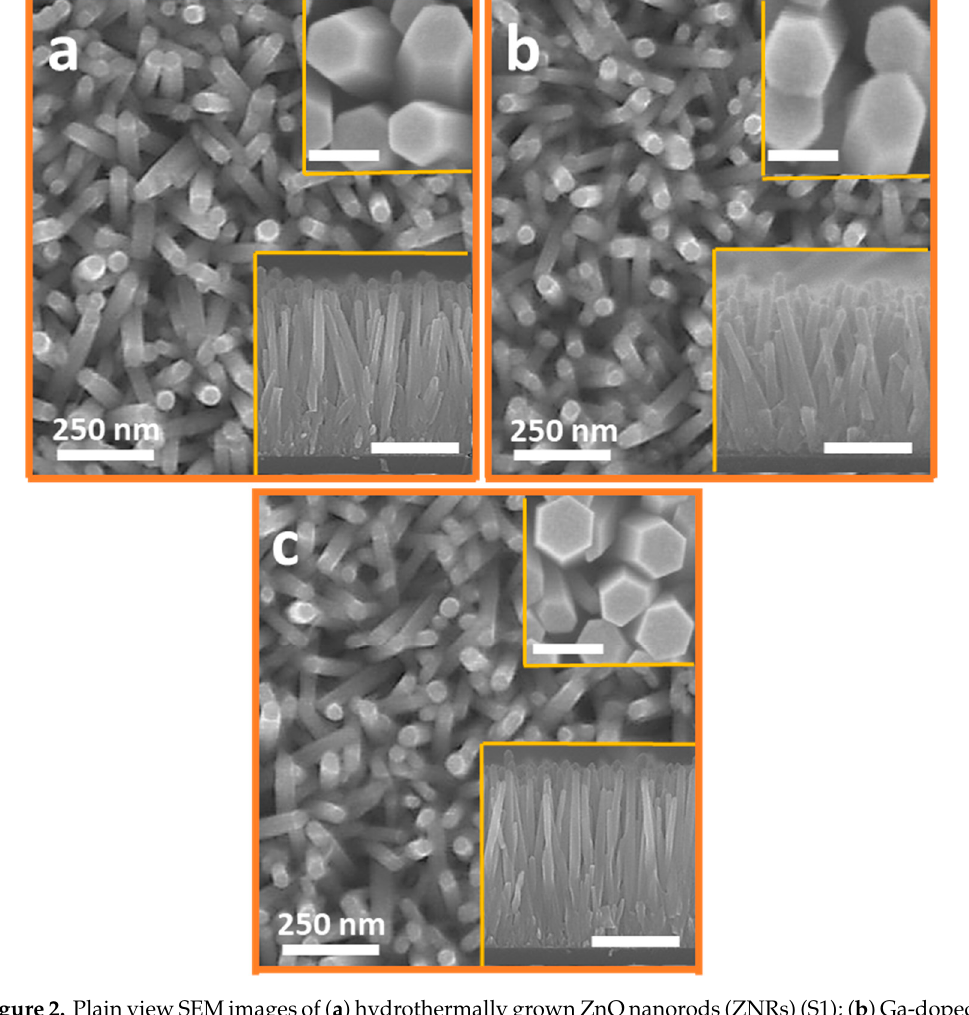
Figure 2. Plain view SEM images of ( a ) hydrothermally grown ZnO nanorods (ZNRs) (S1); ( b ) Ga-doped ZNRs (S2); and ( c ) defect-free microwave-assisted grown ZNRs (S3). The top and the bottom insets are the corresponding magnified images and cross-sectional images of the same ZNRs, respectively. The scale bar in the top insets is 100 nm and in the bottom insets 500 nm.